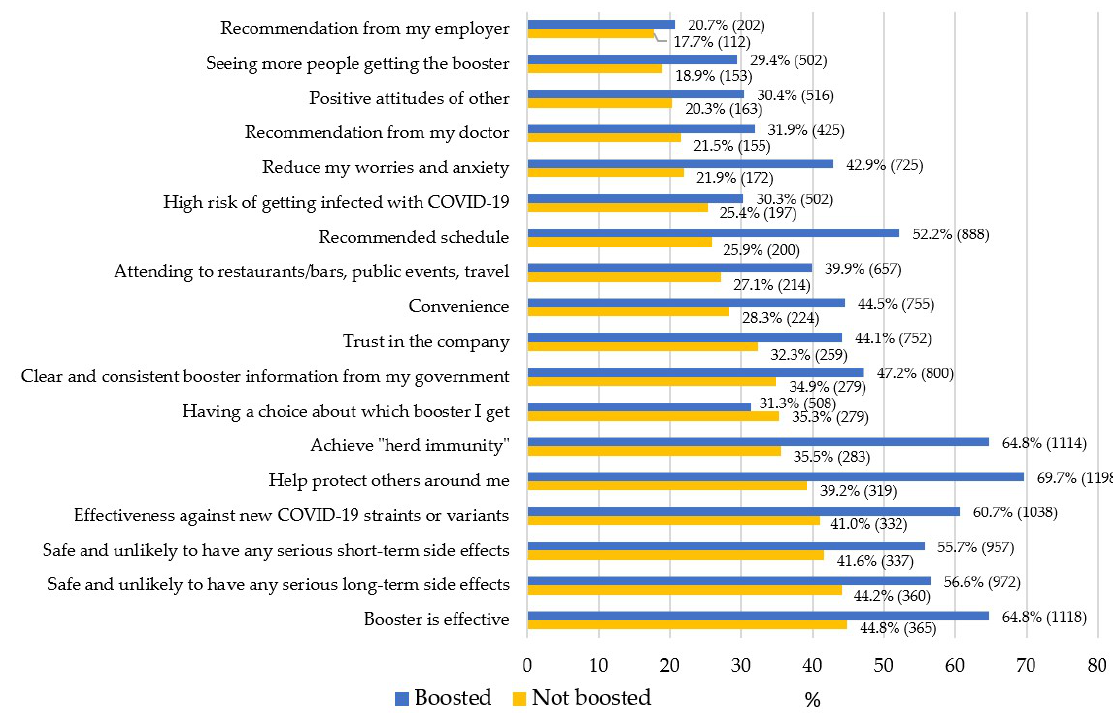
Figure 1. Frequencies of motivators “to a great extent” as a function of booster vaccination status.